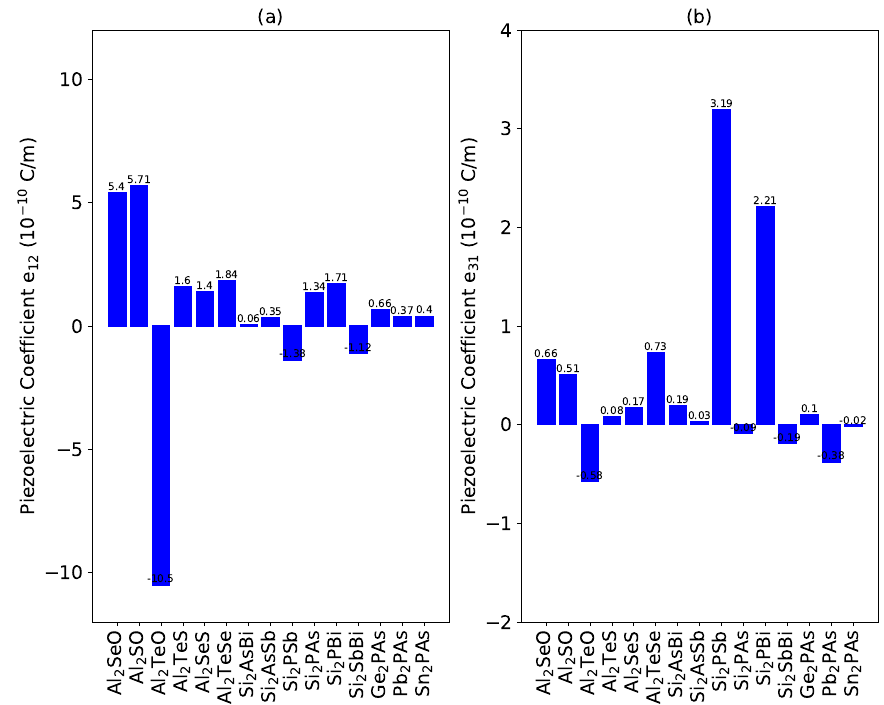
Figure 4. Piezoelectric coefficients ( a ) e 12 and ( b ) e 13 of 15 different structures of A 2 XX’